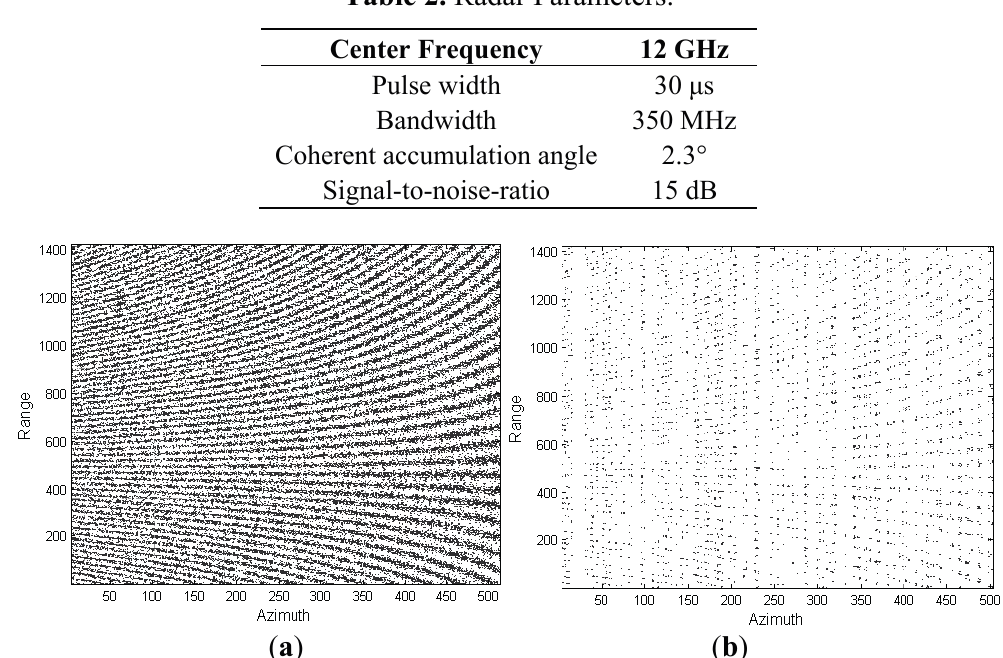
Table 2. Radar Parameters.